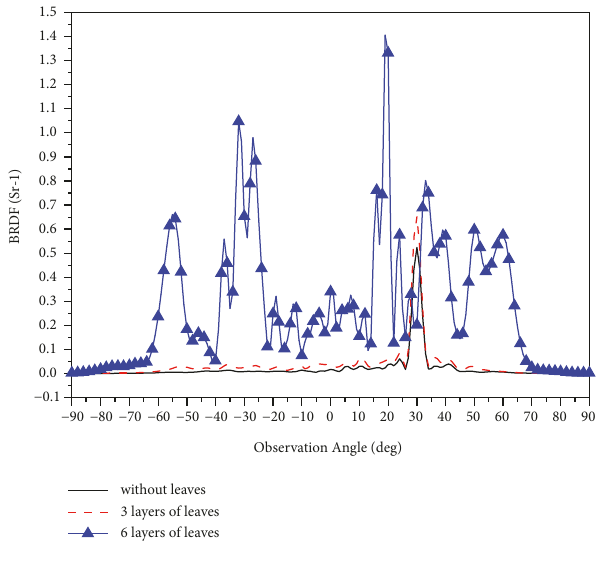
Figure 6: BRDF with different layers of leaves.